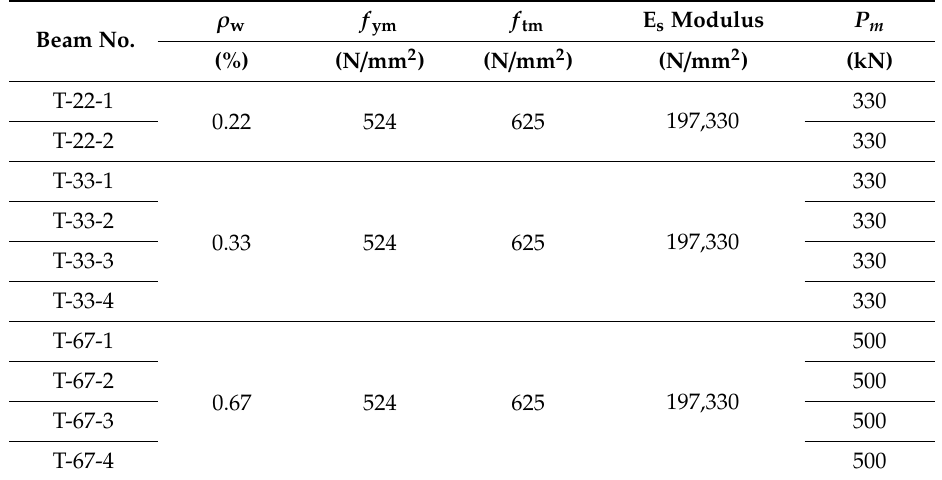
Table 1. Shear reinforcement ratio, properties steel reinforcement (mean values), prestressing forces. Beam No.